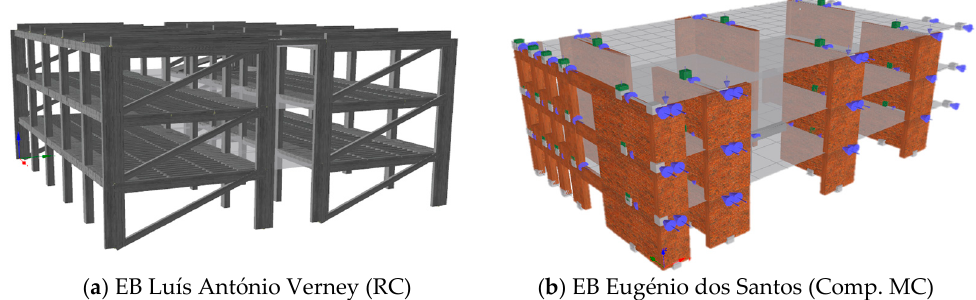
Figure 6. Nonlinear numerical models for structural response assessment at different levels of seismic action intensity for a: ( a ) RC structure; and ( b ) composite masonry–concrete structure.